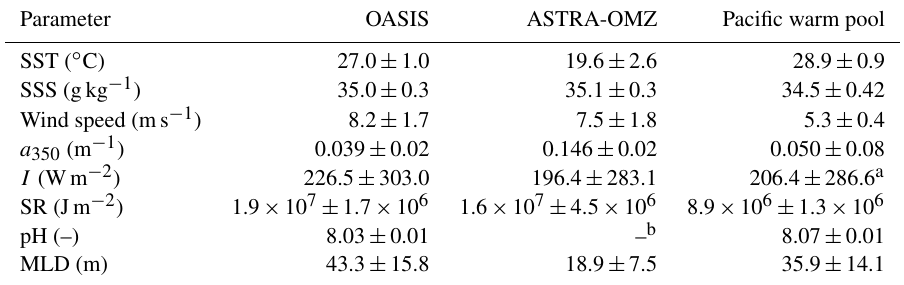
Table 4. Comparison of water properties relevant for OCS production and consumption for the cruises OASIS (Indian Ocean, July– August 2014) and ASTRA-OMZ (eastern Pacific, October–November 2015) with the assumed source region in the Pacific warm pool (15 ◦ N–15 ◦ S, 120–180 ◦ E). Data from cruises are in situ measurements; the data for the Pacific warm pool were extracted from climatolog- ical monthly means from sources for the global model run as specified in the Supplement.